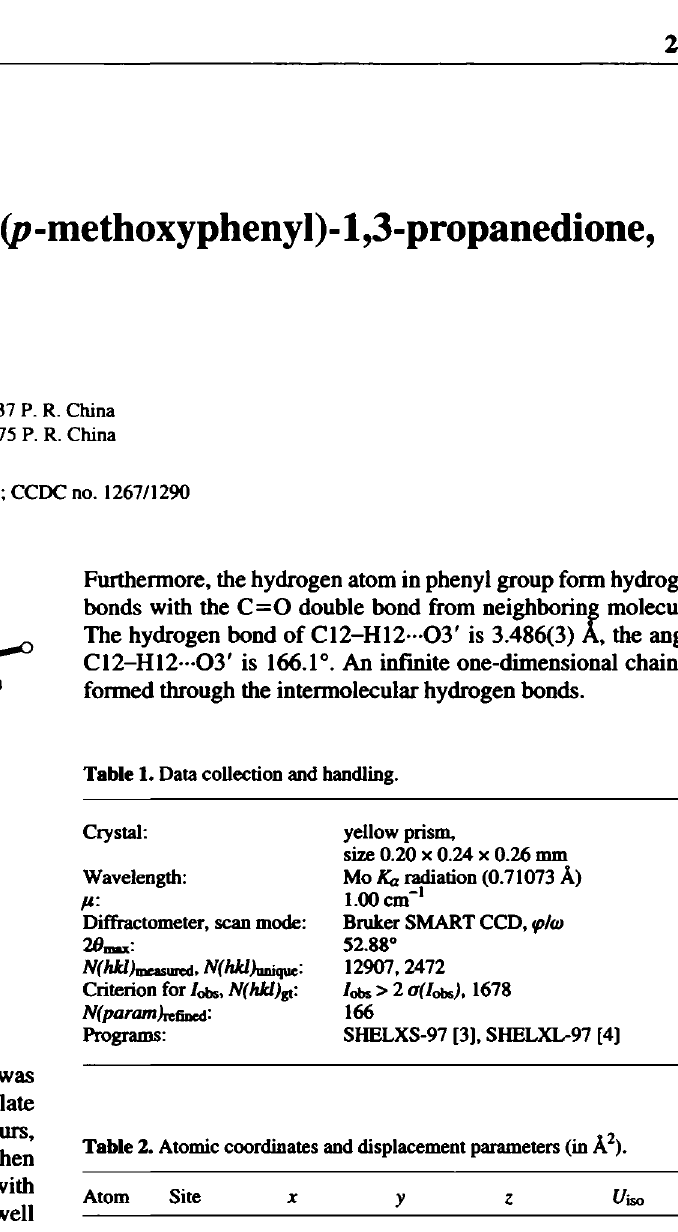
Table 2. Atomic coordinates and displacement parameters (in A 2